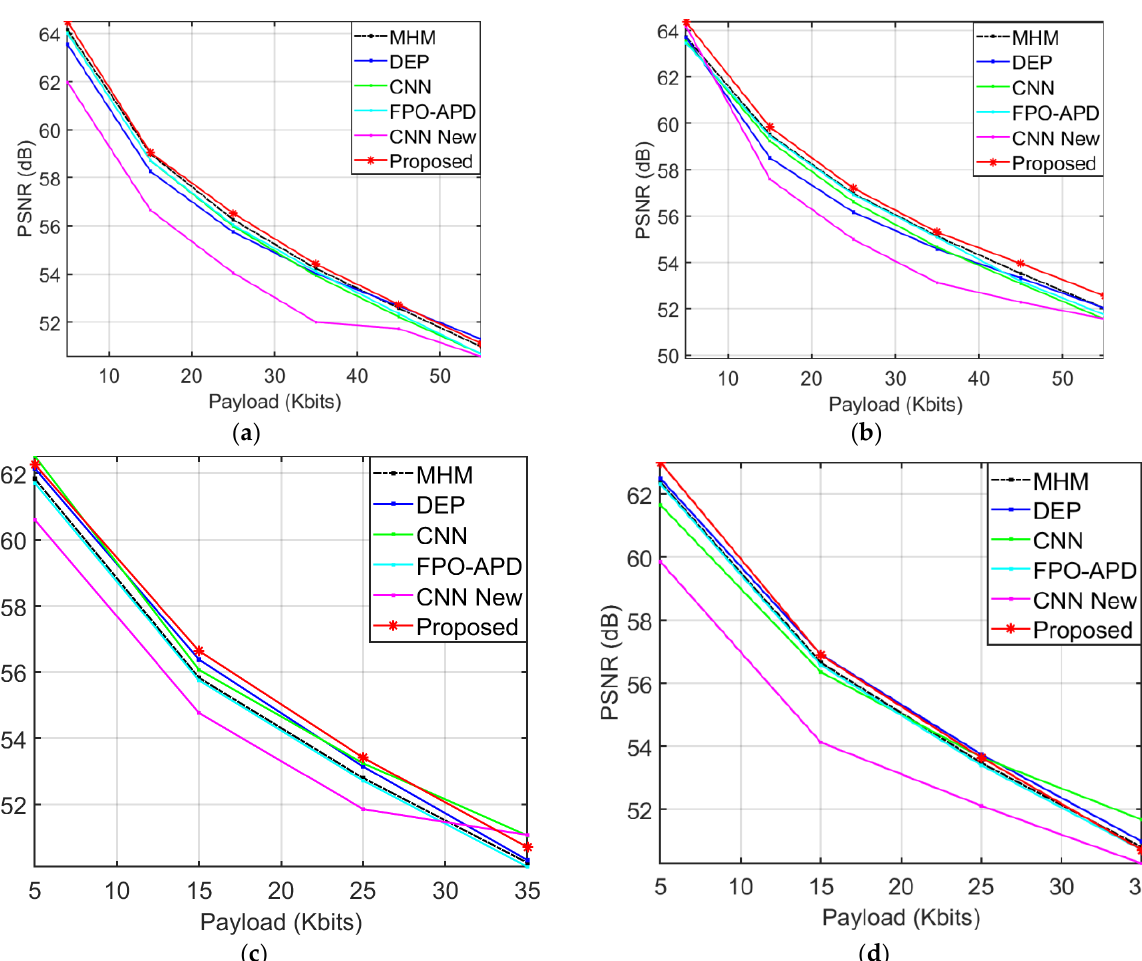
Figure 4. Comparison of average image quality using PSNR.